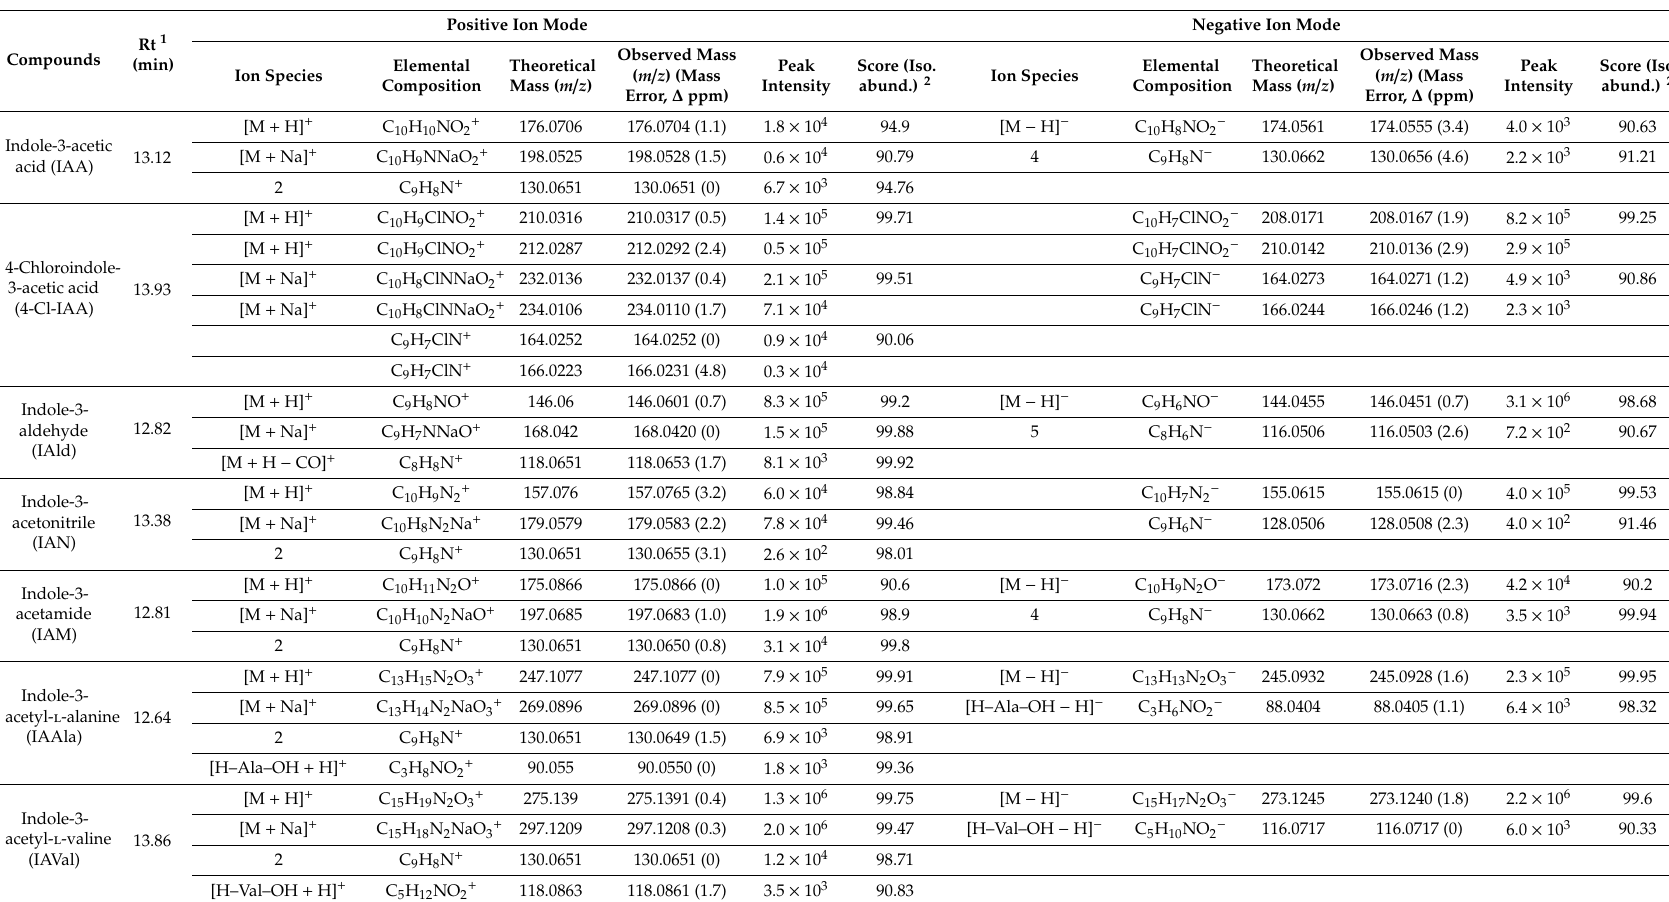
Table 1. High-resolution mass data in ESI positive and negative ion mode and elemental compositions of the molecular and characteristic fragment ions, mass error ∆ , peak intensity, retention time of compounds, and isotopic abundance distribution